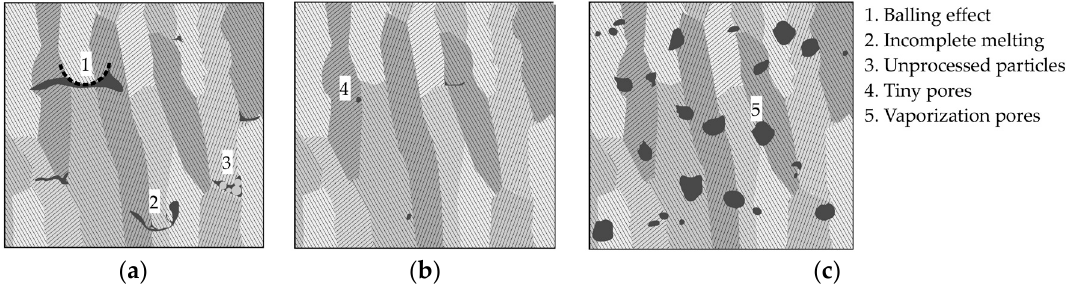
Figure 2. Schematic view of processing-induced pore morphology: ( a ) Lack of fusion pores due to low energy density; ( b ) Minimized porosity obtained for optimized energy density; ( c ) High energy vaporization pores with different sphericity.